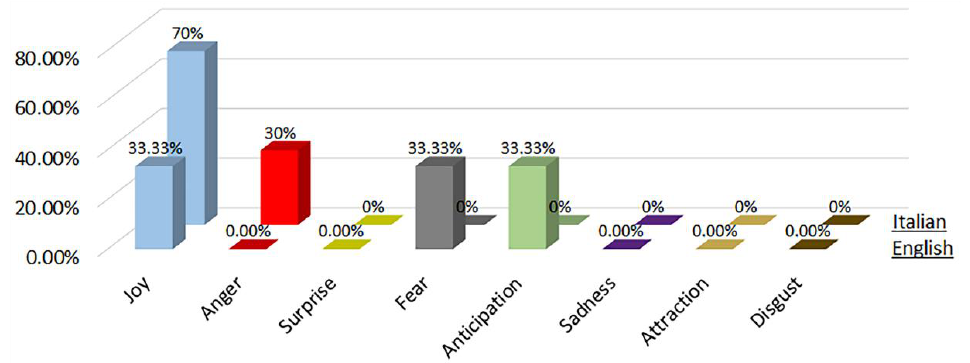
Figure 7. Percentage distribution of every primary emotion for English and Italian words during phase 1 of COVID-19 pandemic.